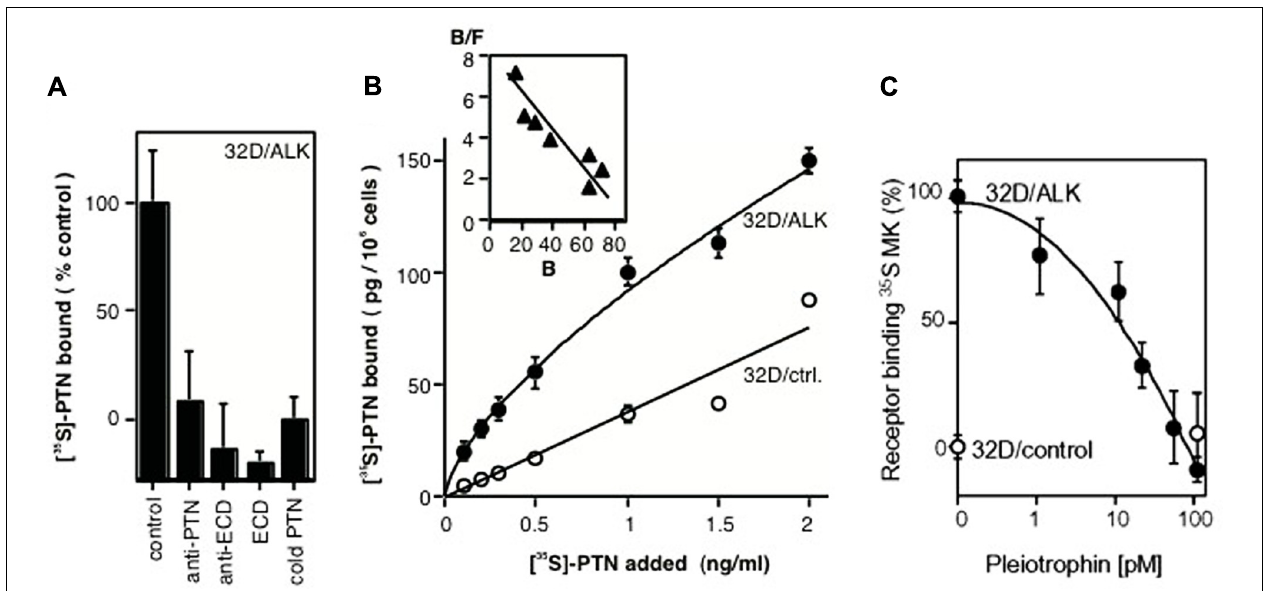
is shown in the inset. Modified from Stoica etal. (2001). (C) Competition of PTN for ALK receptor binding of 35 S-MK. Binding of 35 S-MK to 32D/ALK (filled symbols) and 32D/control cells (open symbols) was competed by different concentrations of PTN. Modified from Stoica etal. (2002).